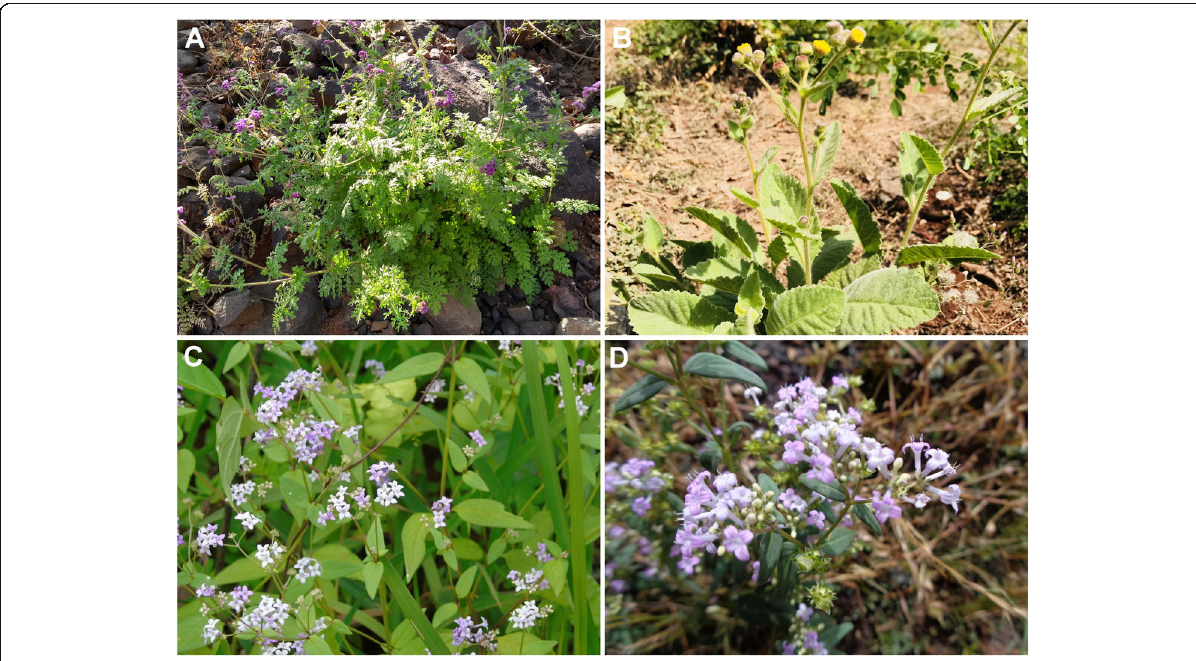
Fig. 1 Flowering stages of the four weeds used in the present study. A Cyathocline purpurea , voucher number - Bot/DNM/51/2020. B Blumea lacera , voucher number - Bot/DNM/52/2020. C Neanotis montholonii , voucher number - BSI/WRC/IDEN.CER./2016/800. D N.lancifolia , voucher number -